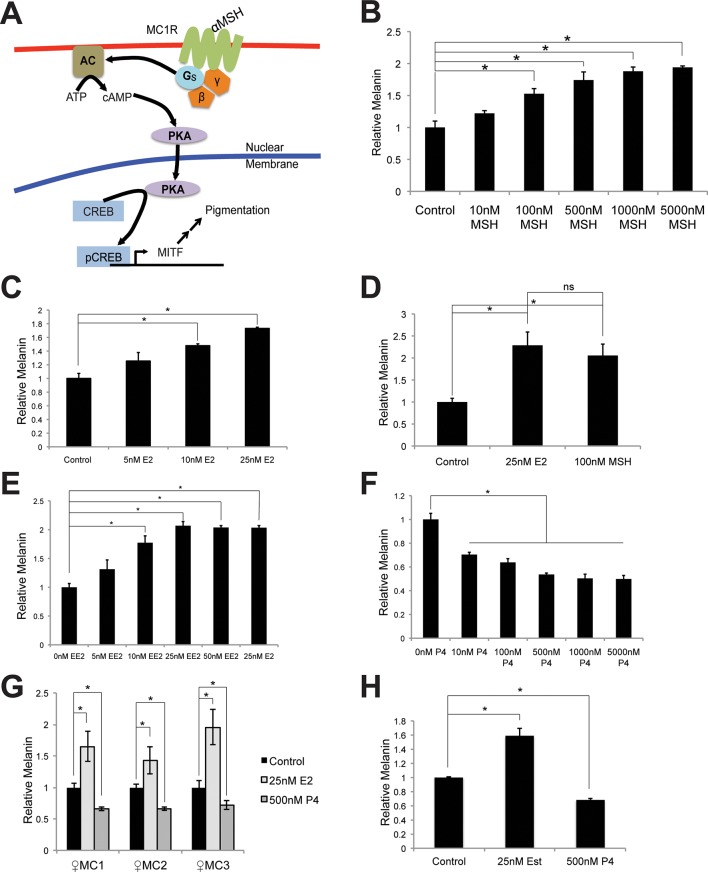
Melanin production in melanocytes.(A) Schematic representation of the classical melanin production pathway. (B) Melanin production in response to αMSH. (C) Melanin production in response to estrogen (E2). (D) Melanin production by melanocytes treated with vehicle, αMSH, or estrogen. (E) Melanin production in response to ethinyl estradiol (EE2). (F) Melanin production in response to progesterone (P4). (G) Melanin production in response to estrogen and progesterone using iPS-derived female melanocytes. (H) Melanin production in response to estrogen and progesterone using facial, aged-adult melanocytes. n=3 biologic replicates for each experiment. Error bars denote +/- s.d., *p<0.05.